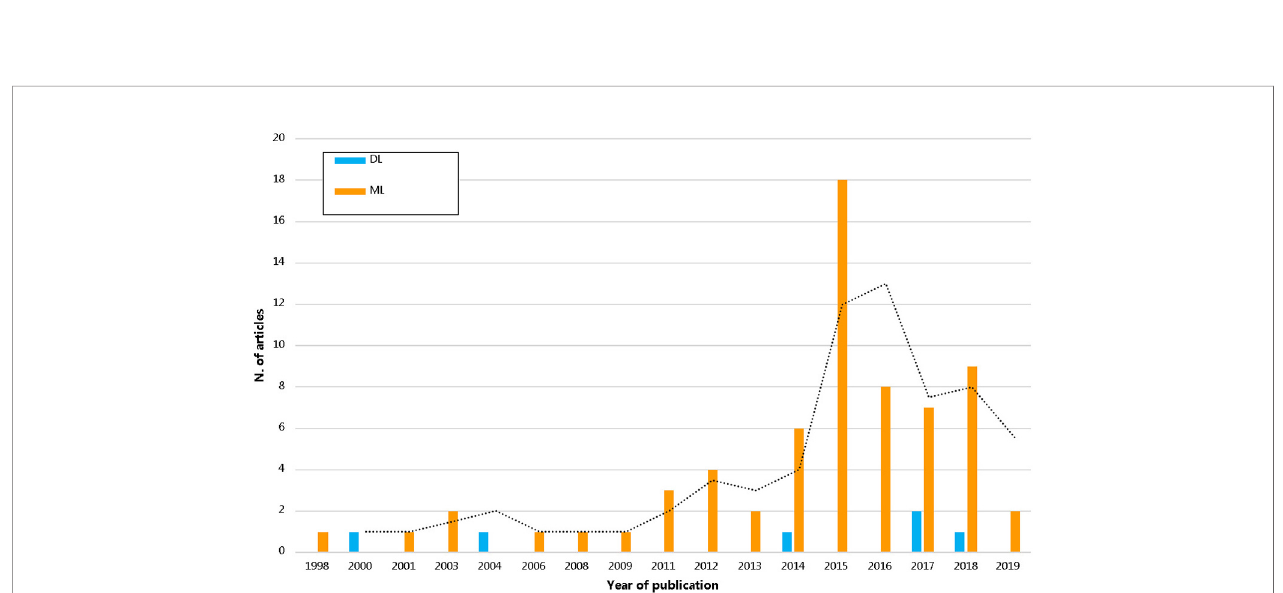
FIGURE 3 | The trend of pharmacoepidemiological studies using arti fi cial intelligence by years. DL, deep learning; ML, machine